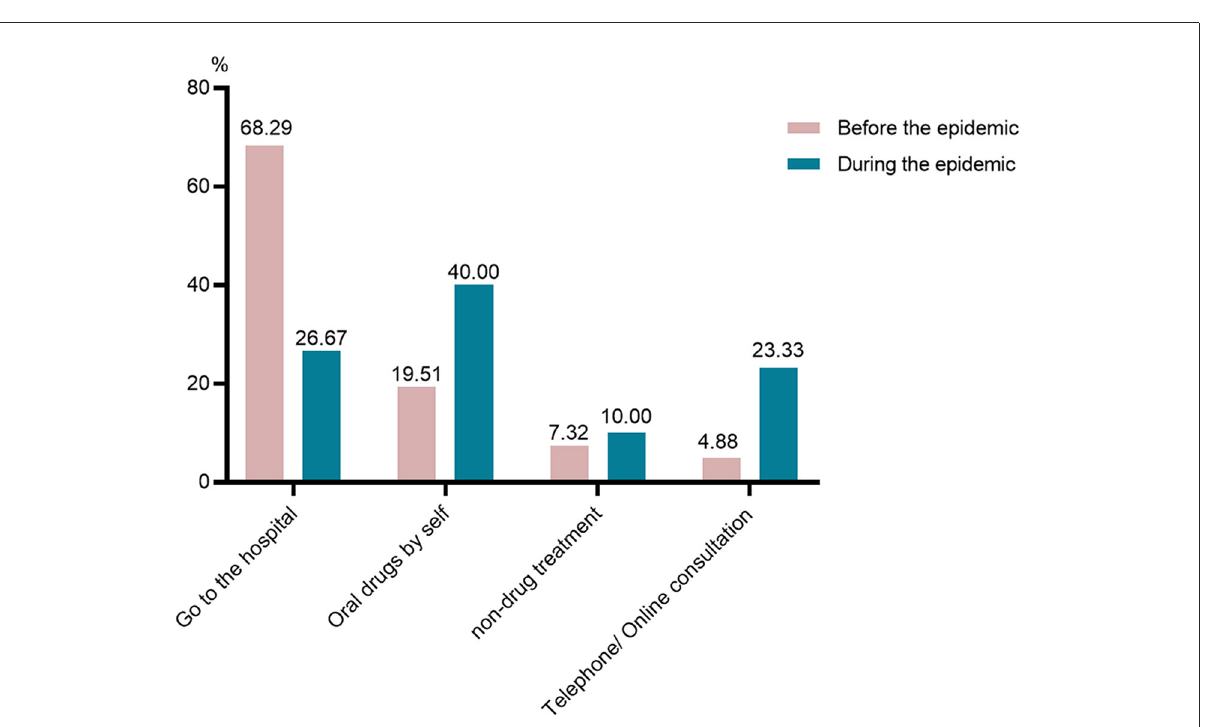
FIGURE2 Different solutions for influenza-like